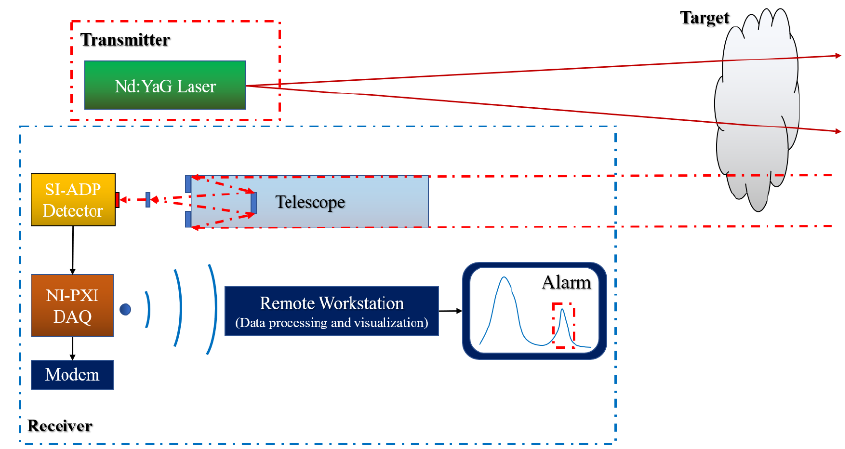
Figure 4. The technical scheme of the compact Lidar system (COLI) in its final configuration.